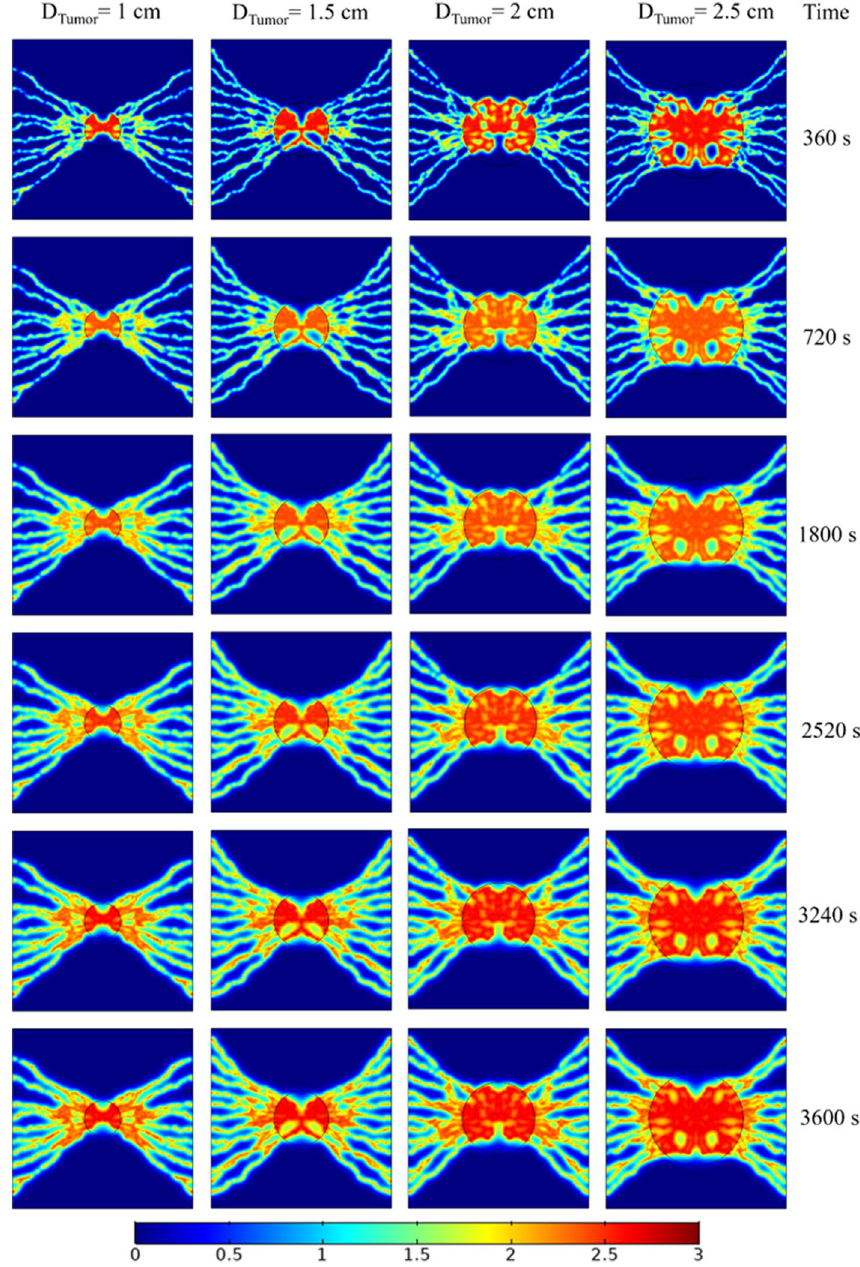
Figure 8. Spatiotemporal distribution of SUV at various times post FDG injection for different tumor